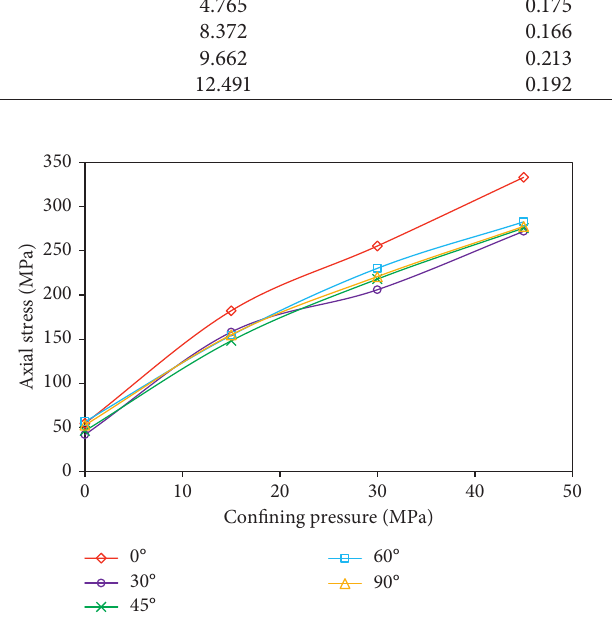
Figure 10: Relationship of confining pressure and axial stress of tight sandstone with different dip